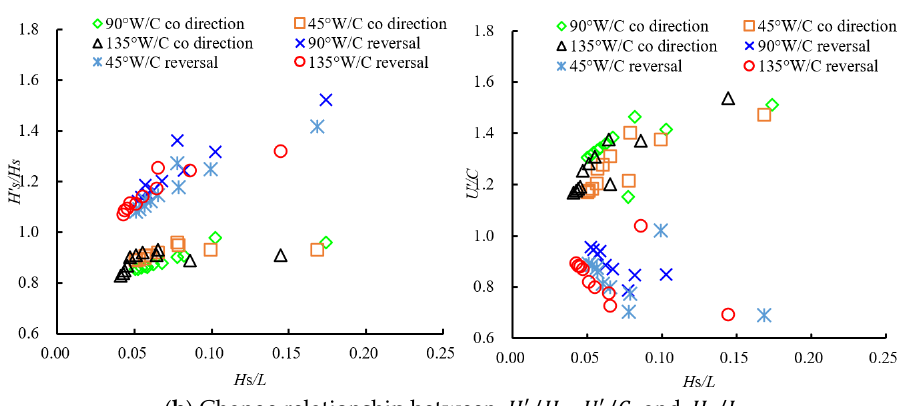
Figure 5. Change relationship between 𝐻 s′ /𝐻 s , 𝑈 ′ /𝐶 and 𝑑/𝐿,𝐻 s /𝐿 , 𝑈/𝐶 .